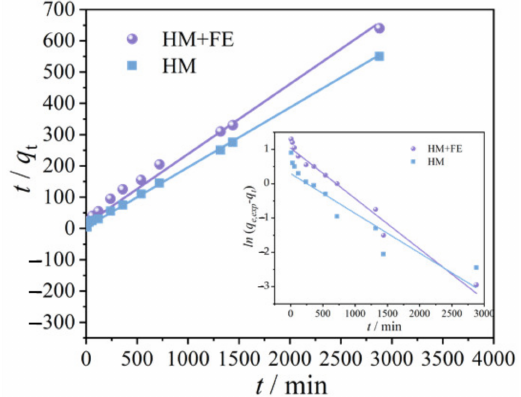
Figure 2. Pseudo-second-order kinetic models of TC on HM and HM+Fe (insert is the pseudo-second- order kinetic